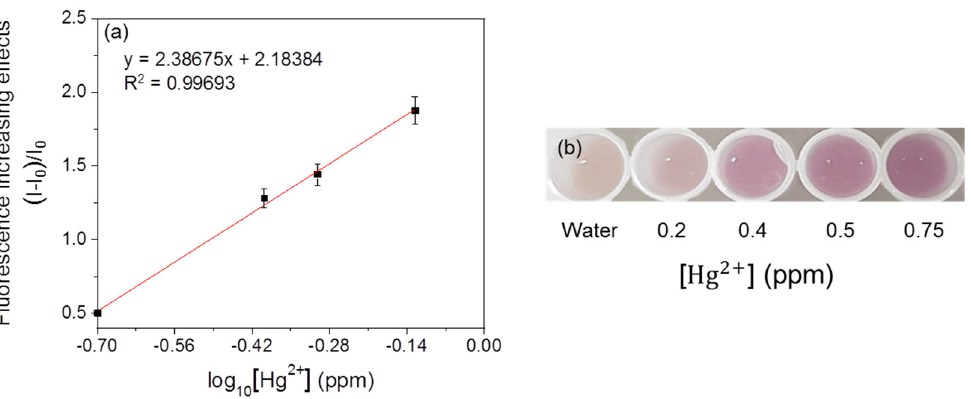
Figure 4. Fluorescent mercury-sensing strain after incubation in M9 medium for 3 h. ( a ) linearity and ( b ) visualization of the fluorescent signal.